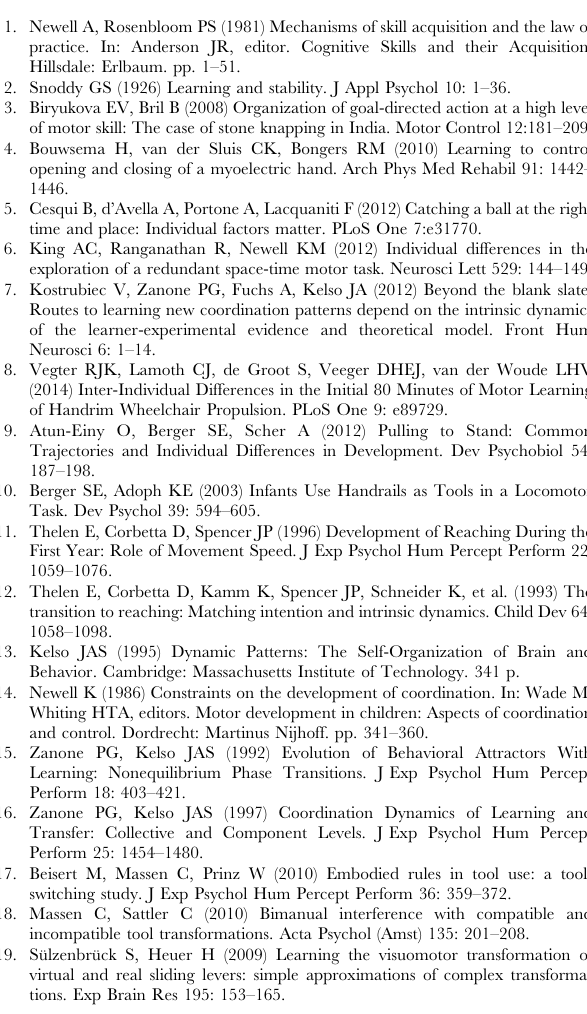
Table S1 Data of analysis variables of all